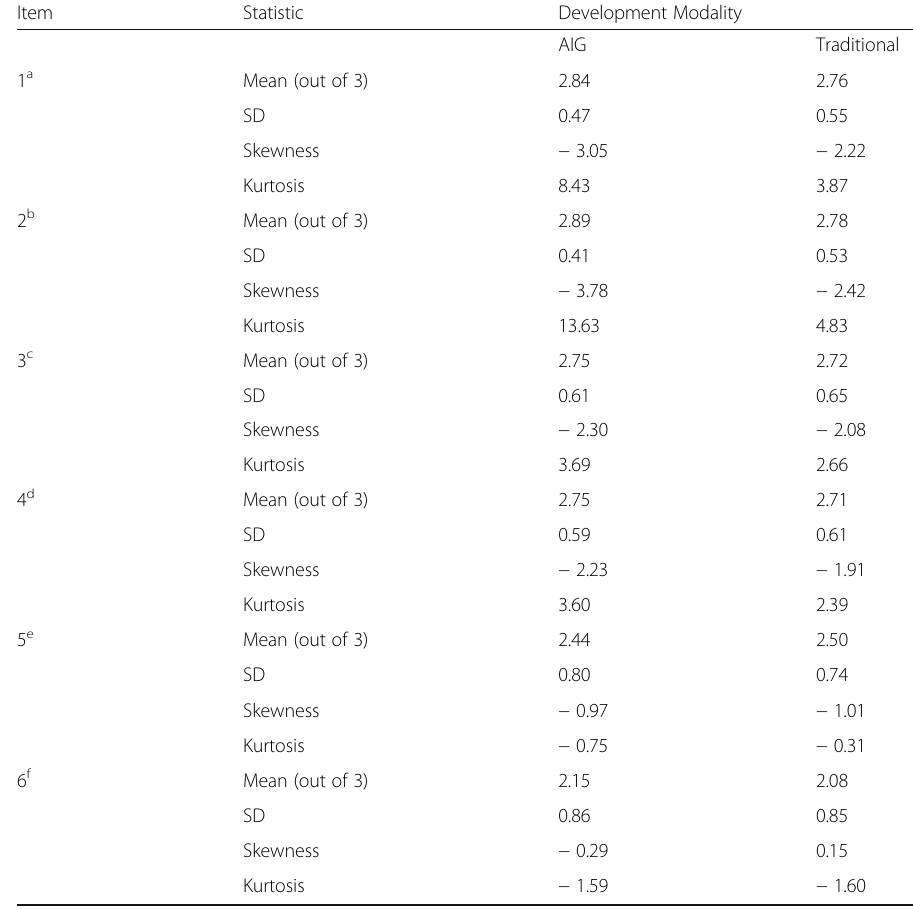
Table 4 Mean, SD, skewness, and kurtosis values for each of the six quality metrics